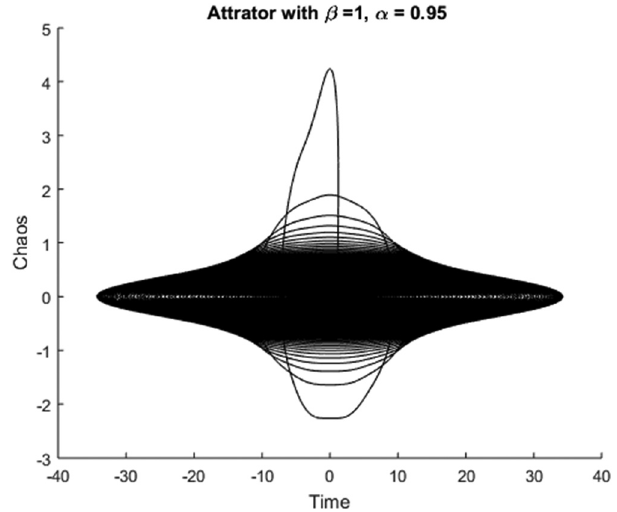
Figure 5: Chaos with the generalized Mittag - Le ffl er